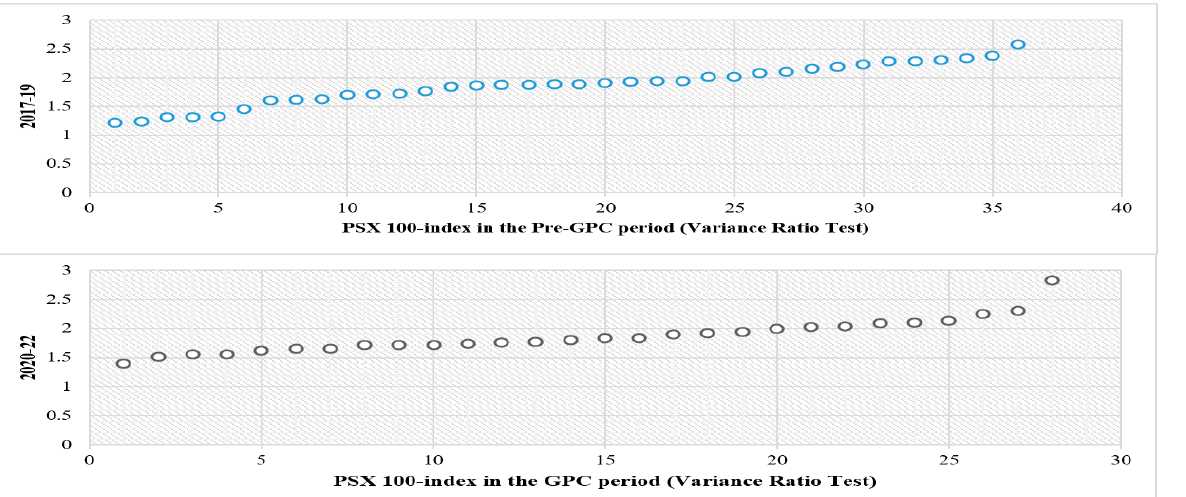
Figure 3. Informational Efficiency of PSX-100 Index in Pre-GFC (2004–2006) and GFC period (2007– 2009).